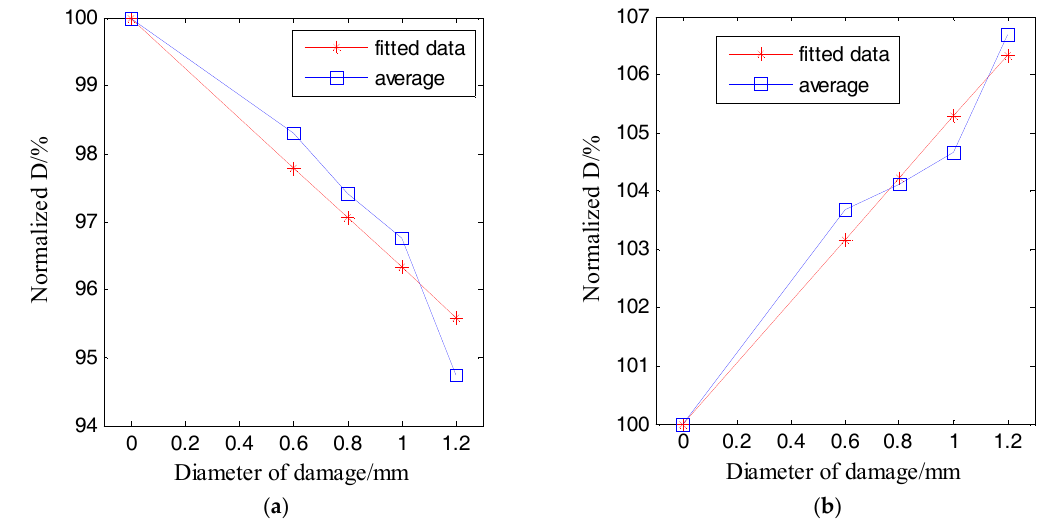
Figure 11. Normalized ultrasonic energy coefficients of damage D1 versus the damage size: ( a ) ultrasound energy diffusion coefficient; ( b ) ultrasonic energy dissipation coefficient.